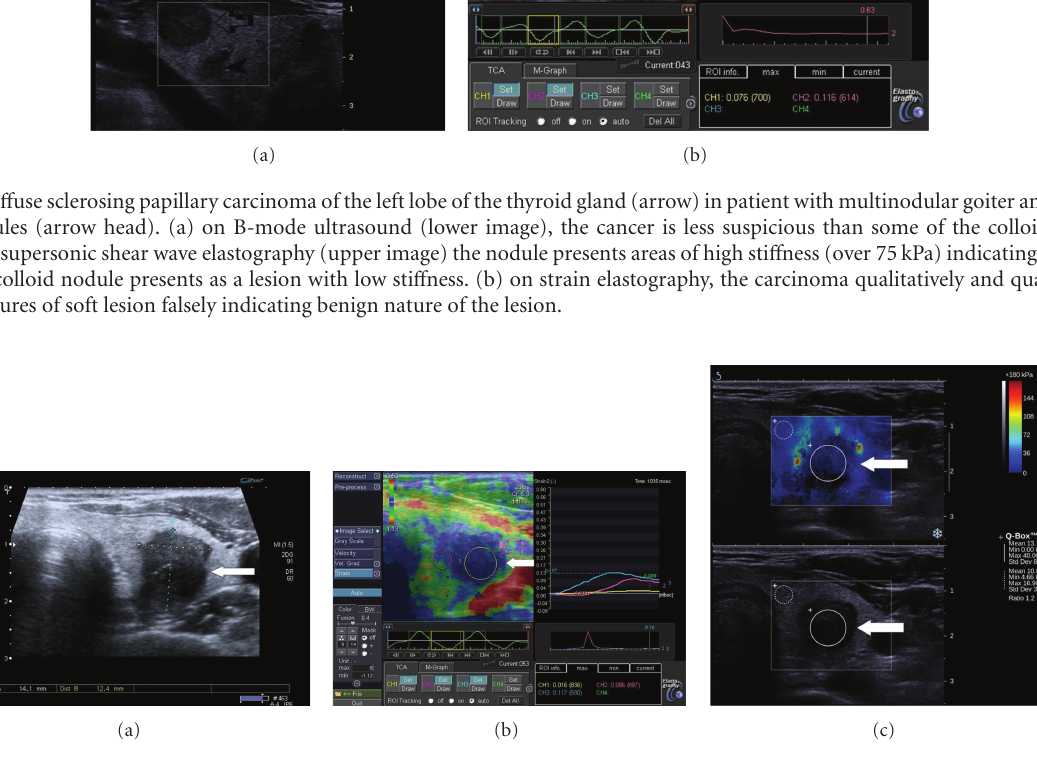
Figure 2: A benign nodule (arrow) of the left lobe of the thyroid gland (with massive degeneration demonstrated on contrast-enhanced ultrasound and in pathologic examination) in patient with multinodular goiter. (a) on B-mode axial section, the nodule is markedly hypoechoic, taller than wide, with somewhat ill-defined margins and high echogenic foci suggesting microcalcifications, a suspicious nodule. (b) on strain elastography, the nodule both qualitatively and quantitatively presents as very hard suspicious of cancer. (c) on supersonic shear wave elastography (upper image), the lesion is very soft, truly indicating its benign nature, with some sti ff calcifications in the